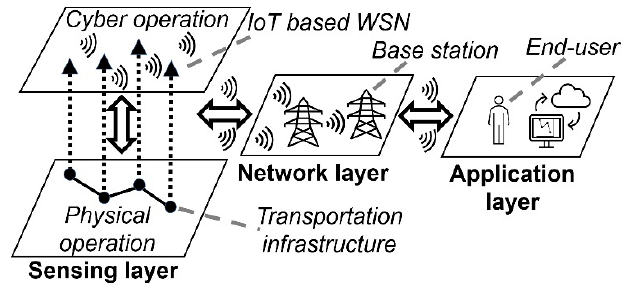
Figure 1. An abstract cyber–physical transportation network example .